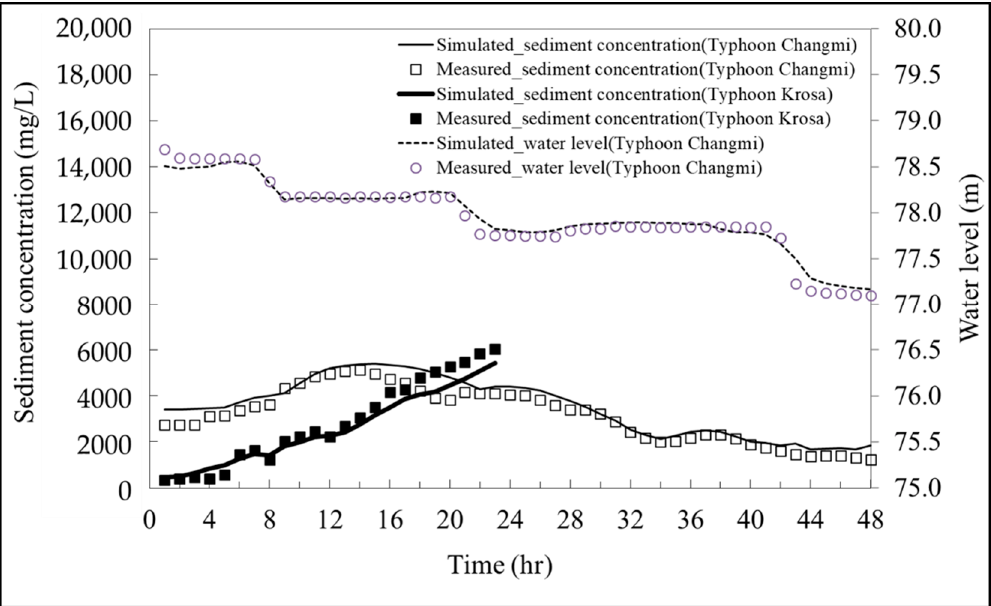
Figure 4. Model validation using data of two typhoon flood events at the Dasi bridge gauge station.